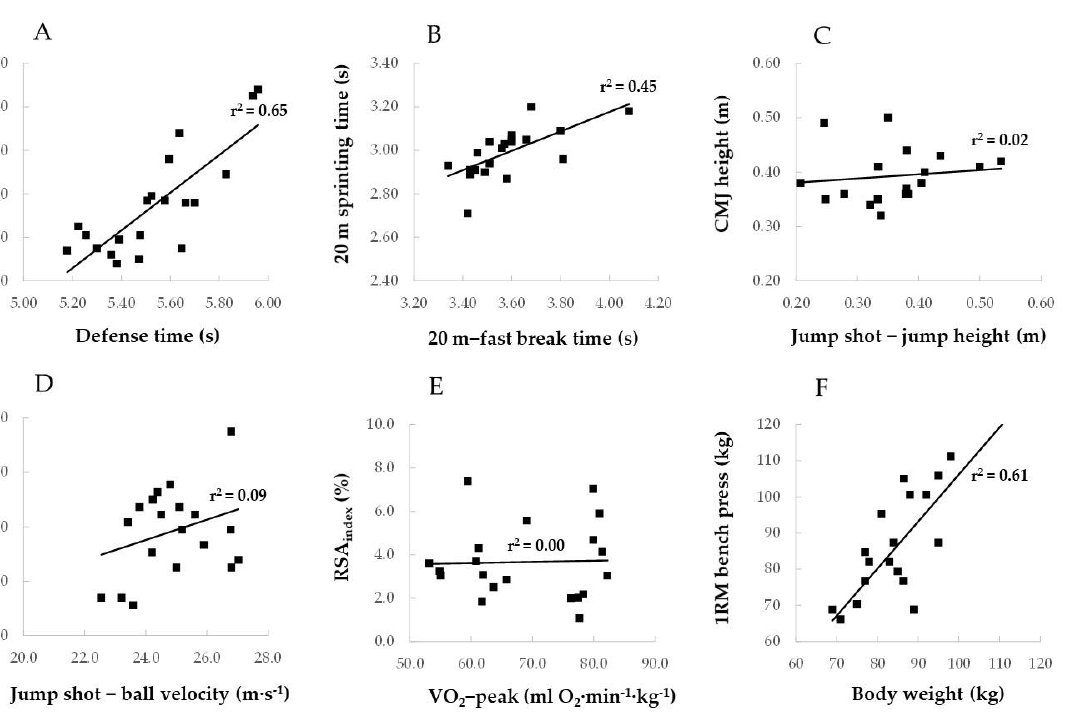
Figure 3. Linear regression analysis scatterplot (r 2 = coefficient of determination) of the defense time in the GBPT (game-based performance test) and t -test time ( A ), 20 m-fast break time in the GBPT and 20 m sprinting test time ( B ), jump shot — jump height in the GBPT and countermovement jump (CMJ) height ( C ), jump shot — ball velocity in the GBPT and standing throw — ball velocity ( D ), peak oxygen uptake (VO 2 -peak) in the GBPT and fatigue index in the repeated sprint ability test (RSA index ) ( E ), and body weight and one repetition maximum (1RM) in the bench press ( F ).